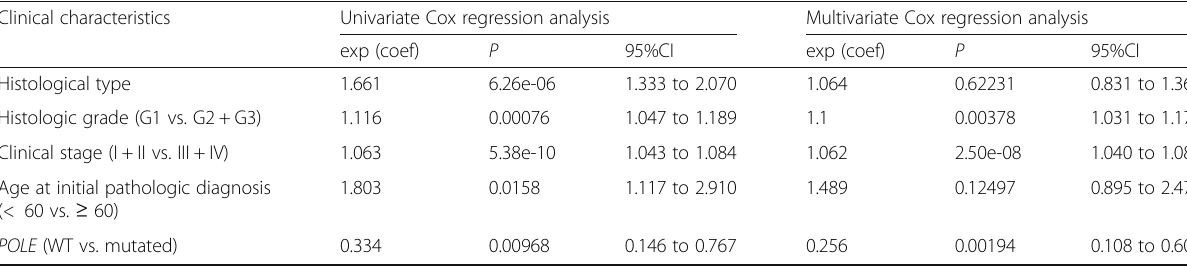
Table 2 Univariate and multivariate Cox regression analysis in endometrial cancer patients Clinical